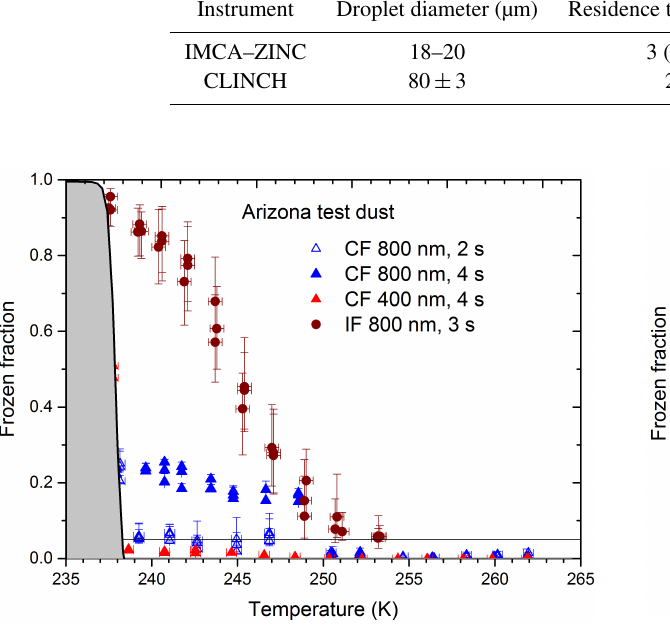
Figure 3. Frozen fraction against chamber temperature for kaoli- nite particles of 400 and 800nm diameter. Contact freezing (CF) for aerosol concentrations of 1000cm − 3 is given by triangles for droplet residence times of 2 and 4s. Immersion freezing (IF from IMCA–ZINC) for 400 and 800nm kaolinite particles and a 3s res- idence time in ZINC is shown by green and brown circles, respec- tively. The gray shaded area shows the homogeneous freezing of droplets determined from blank experiments (without aerosol), and the black horizontal line indicates the lower reliability limit of the measurements determined from the blank signal level observed in experiments without aerosol. Error bars represent the uncertainty in the frozen fraction due to the classification (liquid or ice) uncer- tainty of the IODE detector (Lüönd et al.,